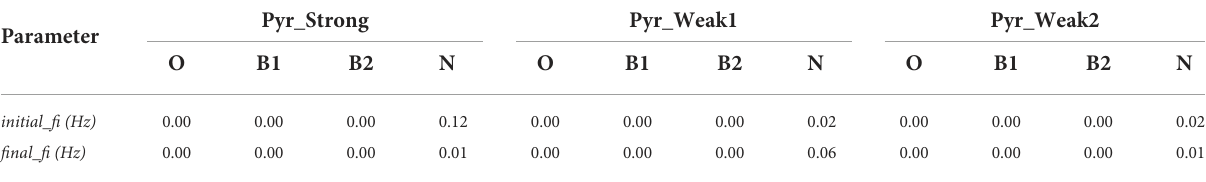
TABLE 2 Root mean squared error (RMSE) values quantifying the match between the published model and the reproductions produced in this study.